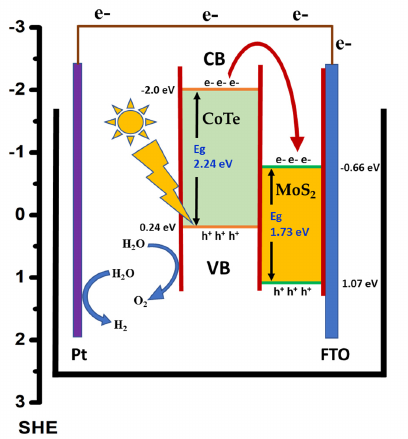
Figure 5. Schematic illustration of alignment of the energy level of MoS 2 /CoTe nanocomposite showing photoelectrochemical water splitting.